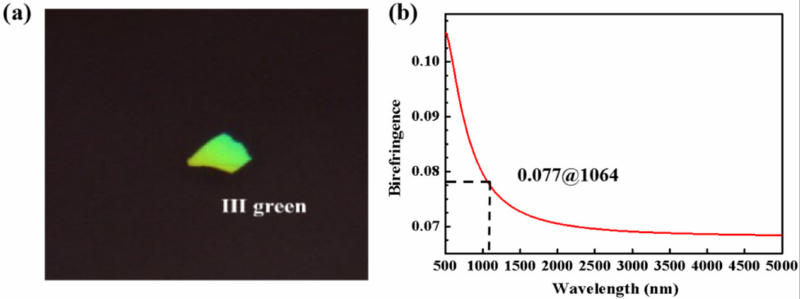
Figure 3. ( a ) The interference color observed for CIBO. ( b ) Birefringence curve of CIBO.